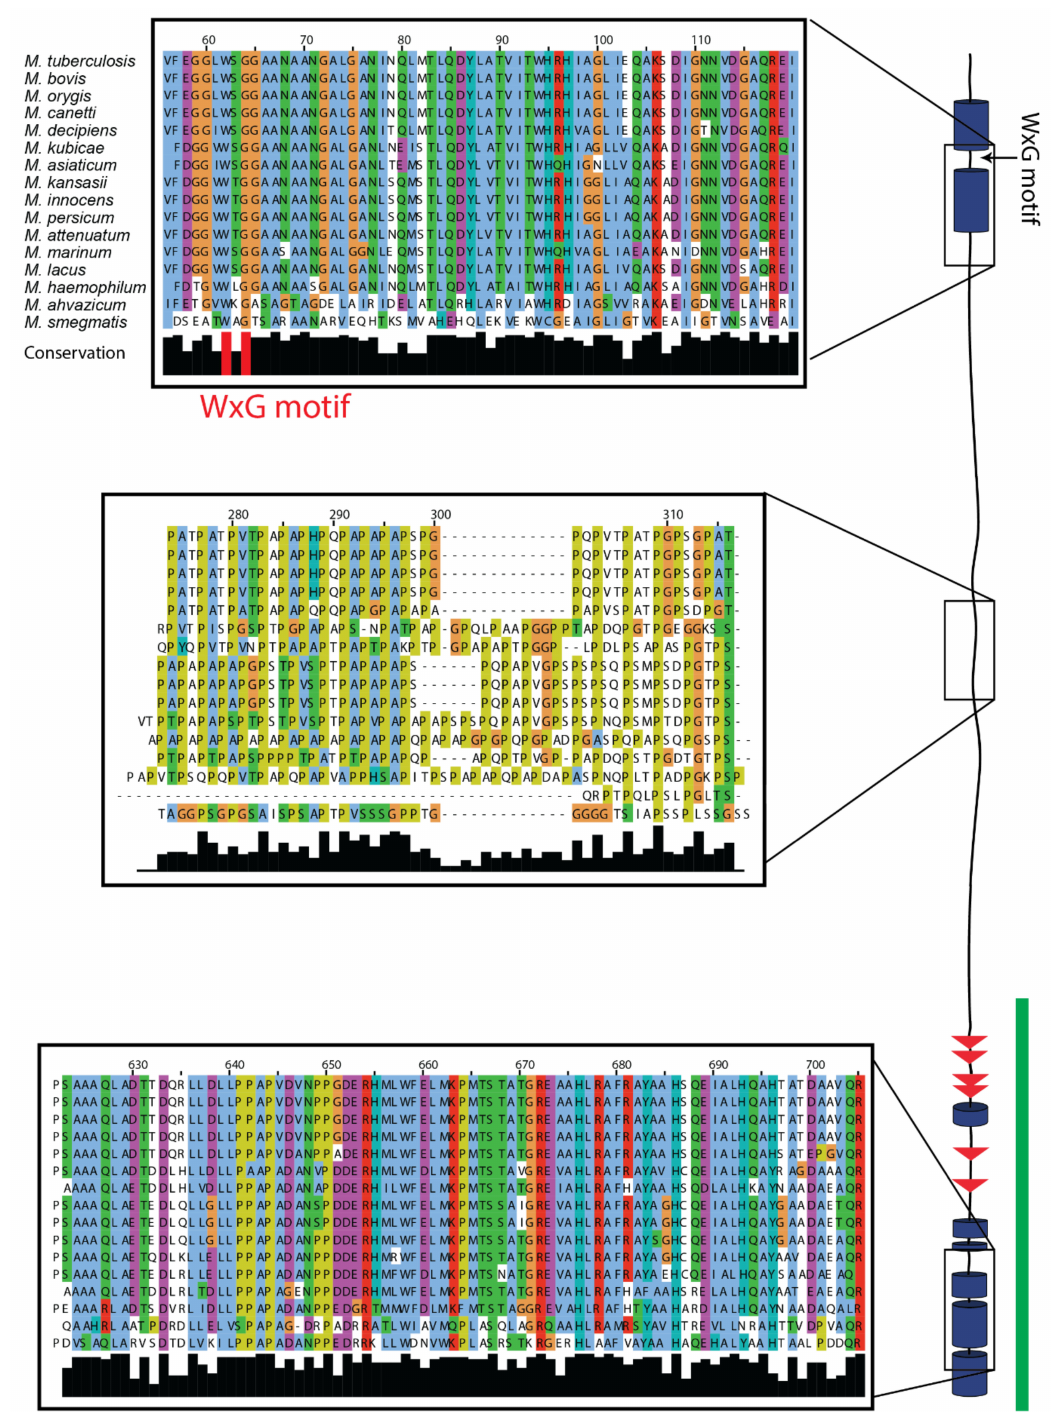
Figure 2. Sequence alignment of EspK from different mycobacterial species and secondary structure prediction. Zoom-in displays representative regions of the different domains. The trypsin-resistant domain identified in this work is highlighted with a green